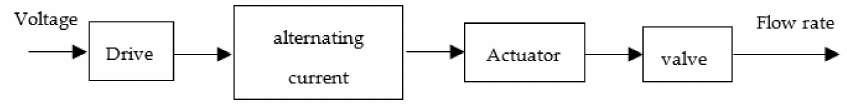
Figure 3. Signal control chart of solenoid